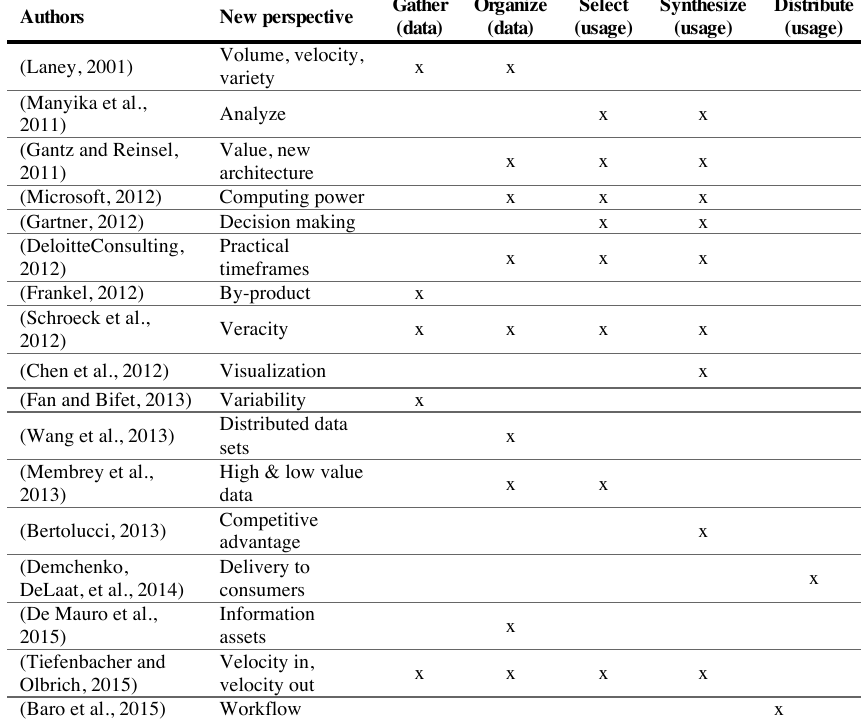
Table 1. Mapping the new perspectives of the big data definitions to the value